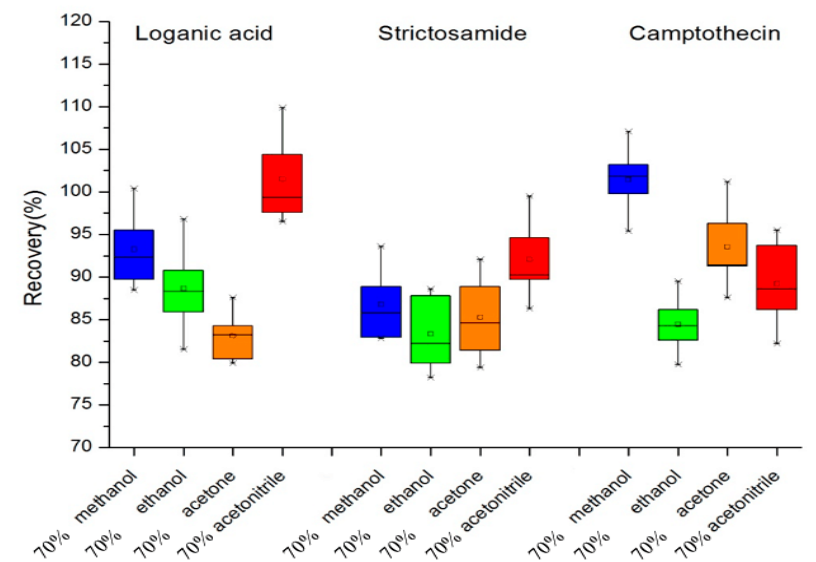
Figure 1. Effects of various extraction solvents on the recoveries of different intermediate compounds by microwave-assisted extraction (MAE). Box-whisker plots show the median (horizontal line inside box), the 25th and 75th percentiles (bottom and top border of box), and the minimum and maximum percentile values of the data (whiskers), respectively.